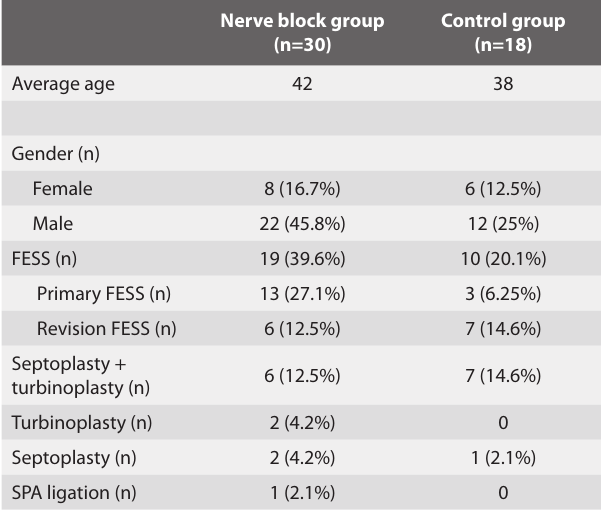
Table 1. Patient demographic and intraoperative details. Characteristics of nerve blockage intervention group versus control group including operation, revision surgery status, sex and